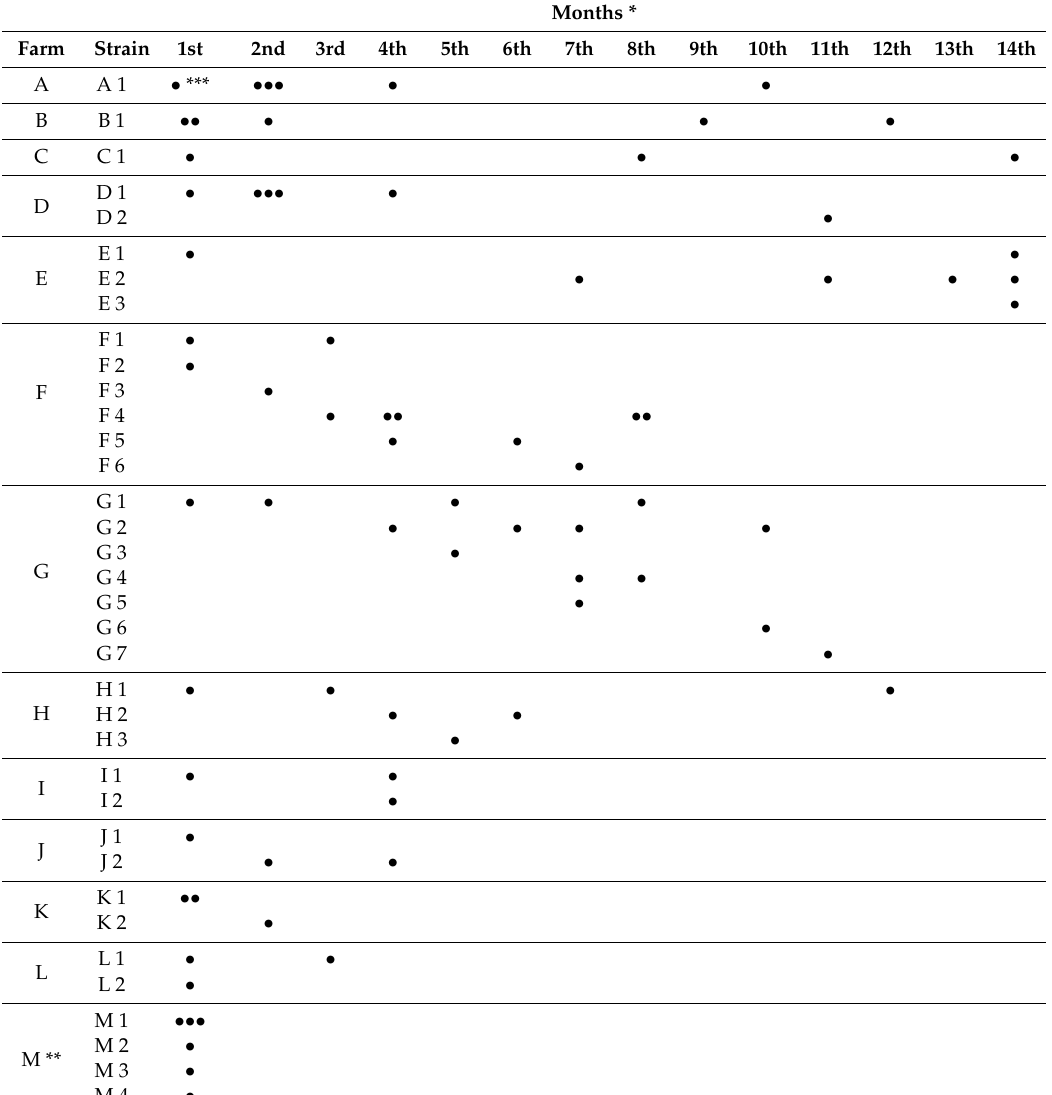
Table A1. Streptococcus dysgalactiae strains isolated from CM milk samples over 14